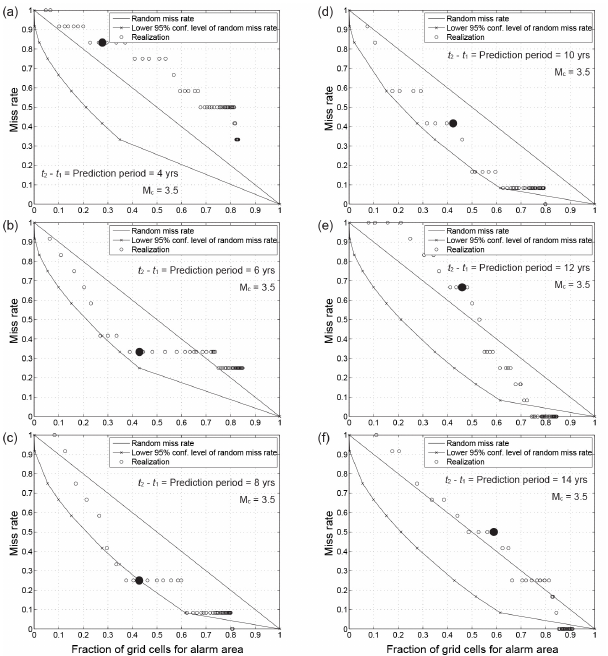
Fig. 9. Molchan’s error diagrams for different change intervals be- tween t 1 and t 2 ( t 2 − t 1 = 4, 6, 8, 10, 12, and 14 years; t 2 = 1 January 1997–28 February 2011). Vertical axis denotes the miss rate, which is defined as the number of M ≥ 6 . 4 earthquakes occurred outside the alarm area relative to the total number of M ≥ 6 . 4 earthquakes. Horizontal axis shows fraction of all grid cells occupied by predic- tion periods following change intervals with the common logarithm of PI values greater than − 0.4. A line connecting (0,1) to (1,0) indi- cates the random miss rate, which shows no statistical significance. A curve with crosses is the lower 95% confidence level of the ran- dom miss rate, which was calculated using the method of Zechar and Jordan (2008). The performance in areas of the plot above and to the right of the curve is not regarded as statistically significant. Open circles were calculated by changing the lower threshold of the common logarithm of PI values above which (toward zero) temporal change in seismic activity is large; the large solid circle is calculated by setting the lower threshold to − 0.4.